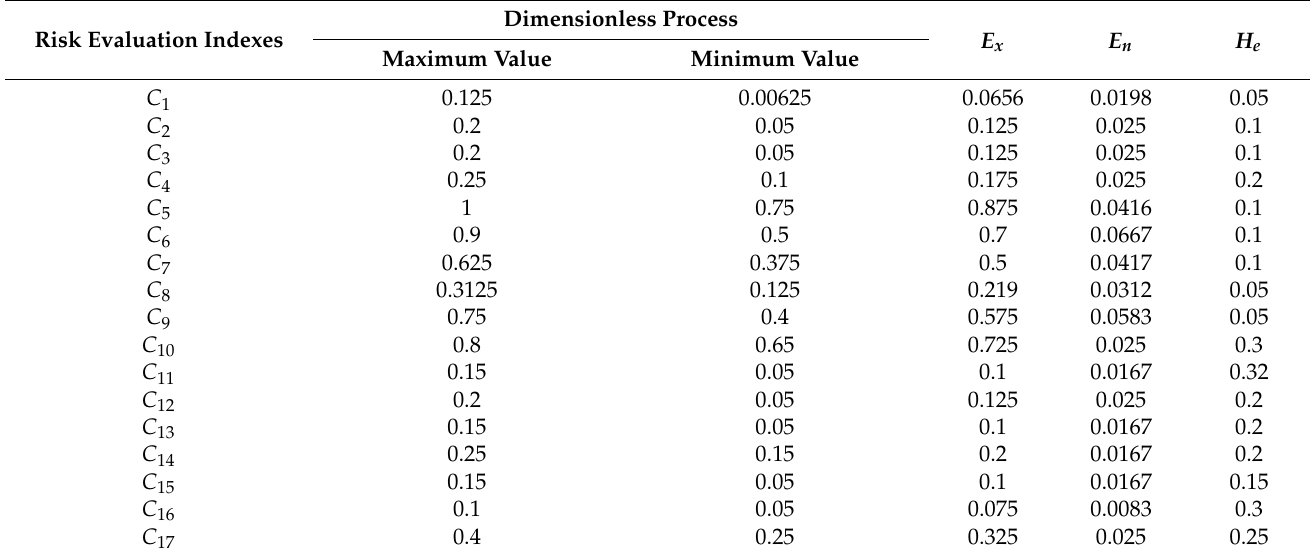
Table 10. Cloud digital features of each risk evaluation index.